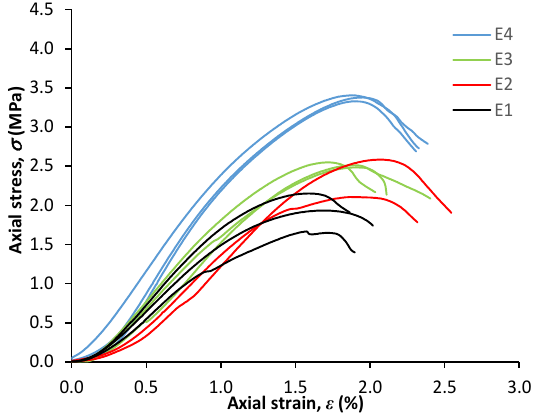
Figure 7. UCT stress–strain curves for CBS specimens with 10% cement.